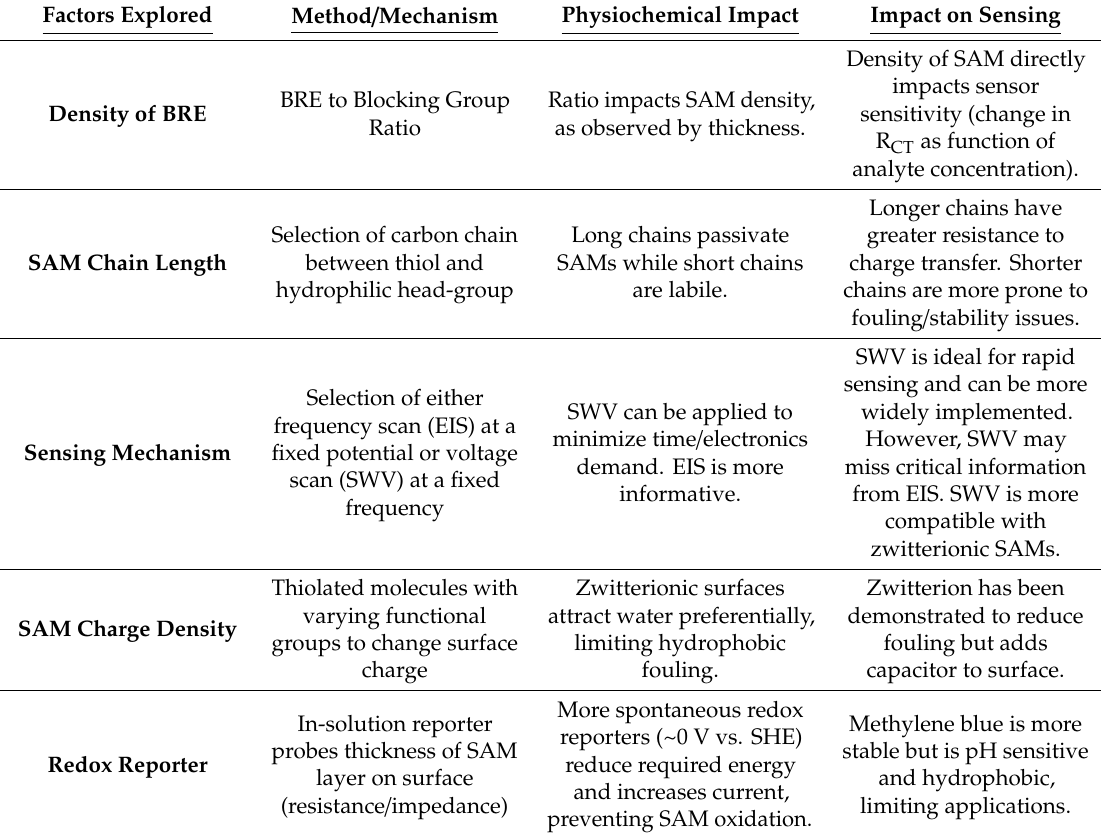
Table 1. Summary table of experiments and findings on how biorecognition element (BRE) density, SAM Selection, Electrochemical Sensing Mechanism and Selection of Redox Reporter Impact Sensing. Factors Explored Method /